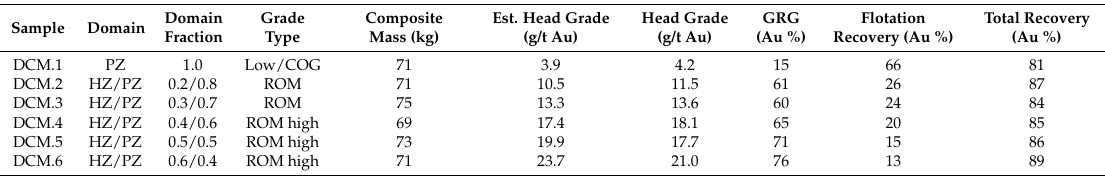
Table 19. Summary of core composite testwork